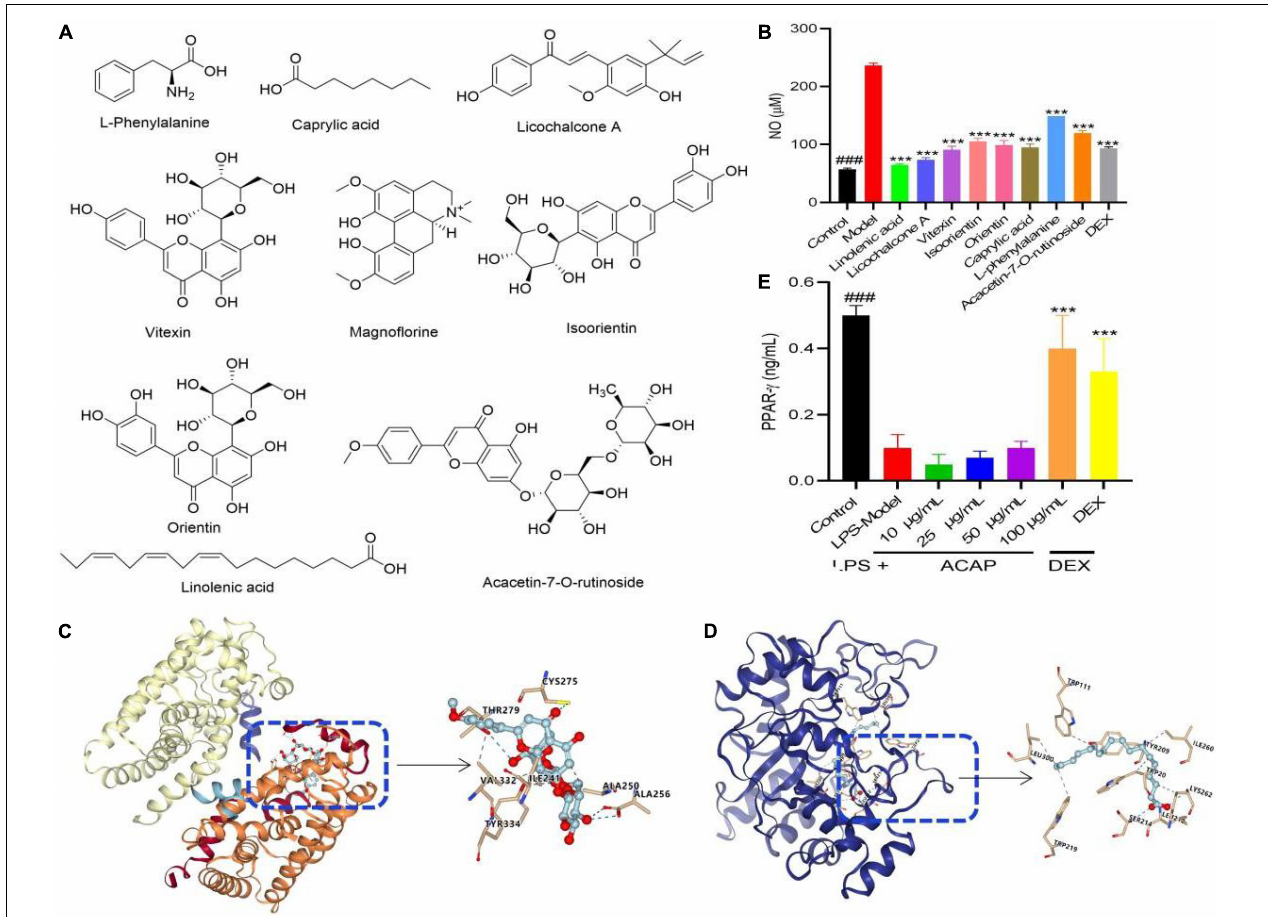
FIGURE 3 | The potential chemical structure of active compounds identified from ACAP (A) , the inhibitory effect of eight compounds on NO production (B) , the affinity and binding sites between the target AKR1B1 and the compound linolenic acid (C) , the target AKR1B1 and the compound acacetin-7-O-rutinoside and AKT1 (D) in the molecular docking test, and the activation effect of ACAP on PPAR- γ (E) . ### Represent the significant difference between control group and model group, p < 0.001; *** p < 0.001 represent the significant difference between model group and drug treated